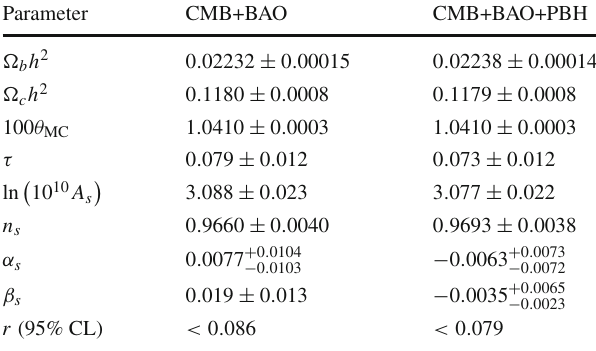
Table 1 The 68% limits on the cosmological parameters in the (cid:2) CDM+ r + α + β s s modelfromthedatacombinationsofCMB+BAO and CMB + BAO + PBH respectively Parameter